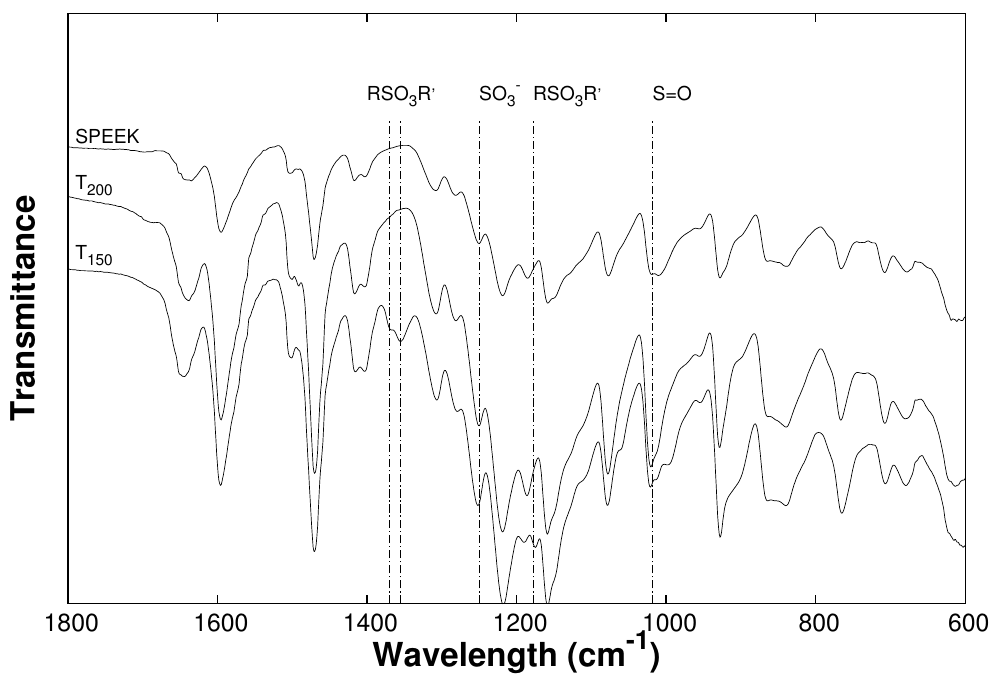
Figure 3. FT-IR of non-crosslinked and crosslinked SPEEK with the molar ratio SPEEK:crosslinker 3:1 ( T 150 = cSPEEK prepared at 150 °C, T 200 = cSPEEK prepared at 200